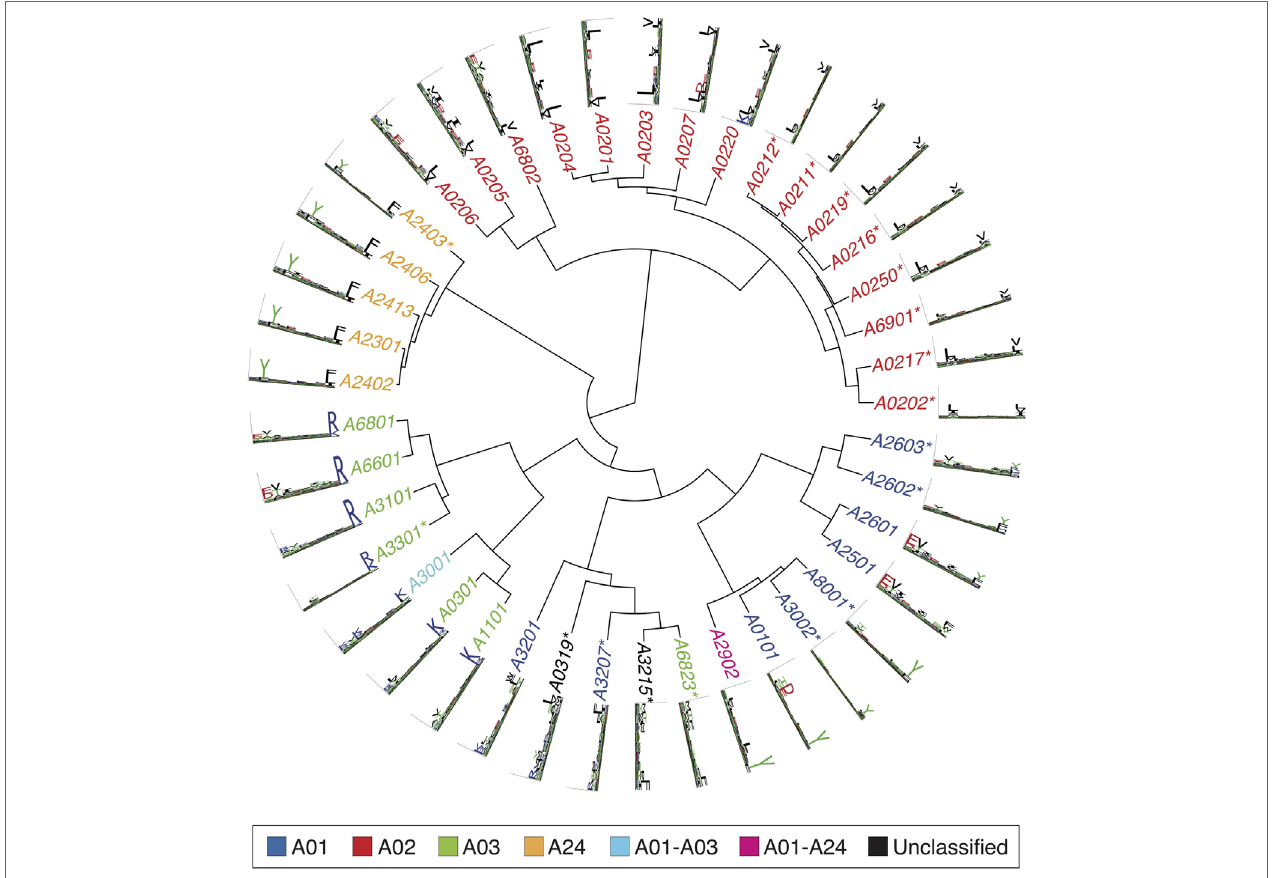
FiGURe 2 | Hierarchical clustering of HLA-A alleles based on their binding specificity. Stars indicate cases where only in vitro binding data were available to generate the motifs. In all other cases, only mass spectrometry data were used. Name colors and their descriptions in the legend indicate supertypes as defined in Ref.